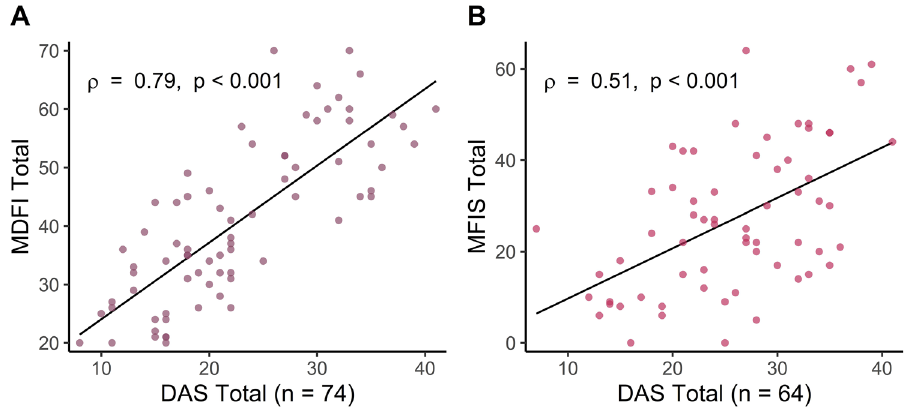
Figure 3. There were strong, positive relationships between total scores on the apathy questionnaire (the DAS), and both fatigue questionnaires. ( A ) Relationship between the DAS and the MDFI. ( B ) Relationship between the DAS and the